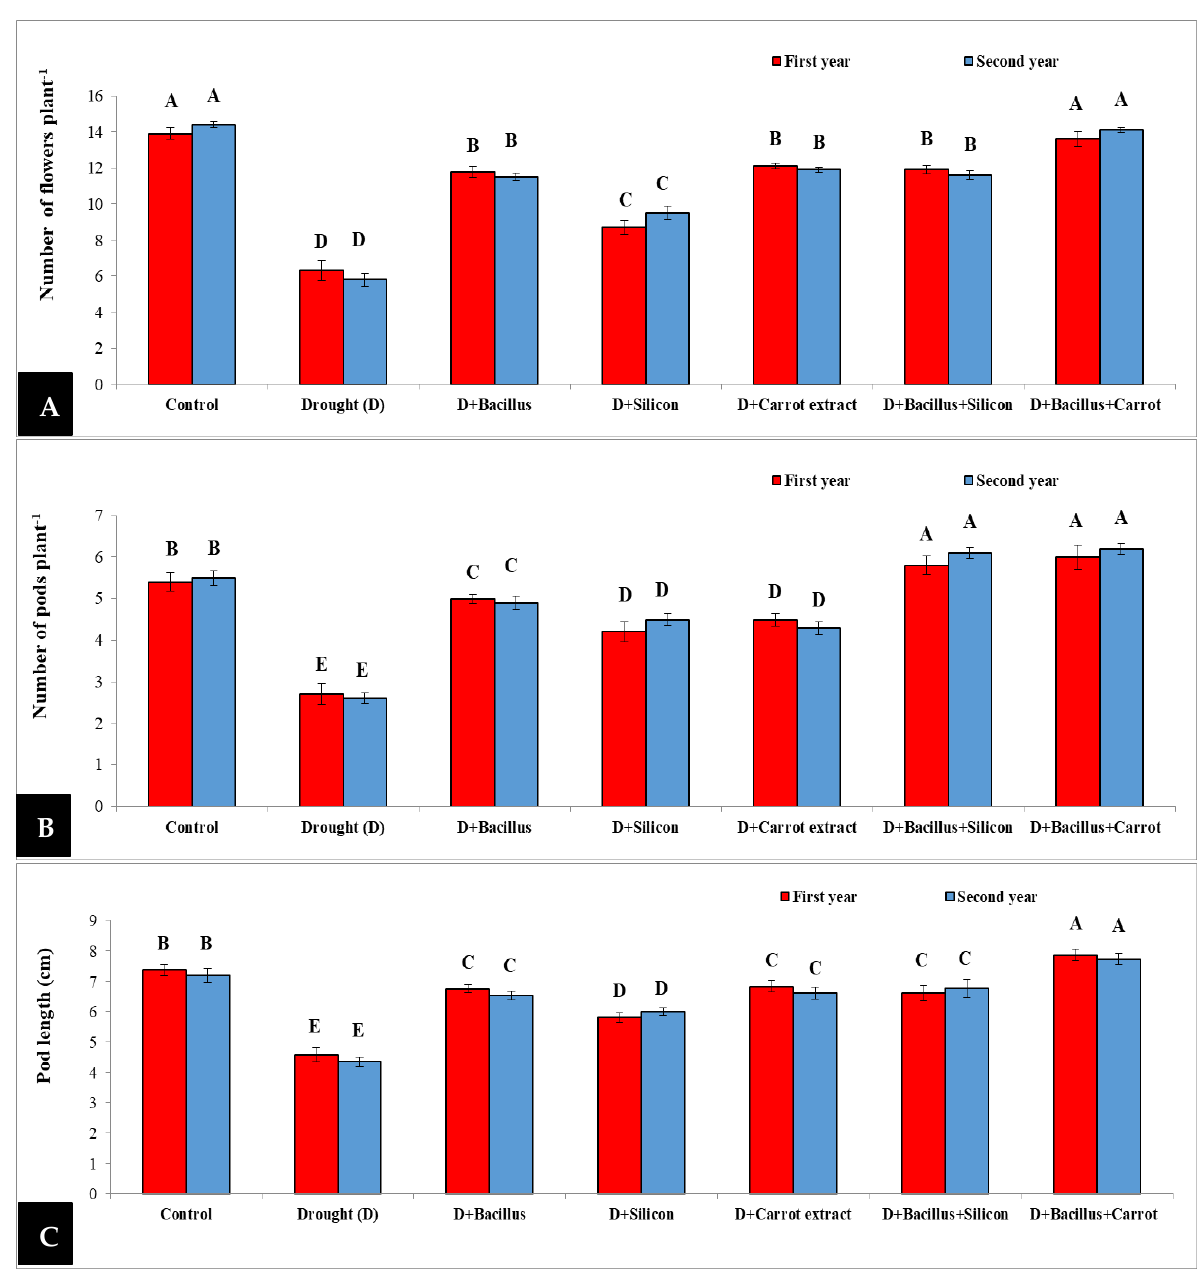
Figure 2. Effect of Bacillus thuringiensis , silicon and carrot extract on number of flowers plant − 1 ( A ), number of pods plant − 1 ( B ) and pod length ( C ) of drought-stressed pea plants during 2019/2020 and 2020/2021 seasons. Different letters on the columns show significant differences between the treatments according to ANOVA, and Duncan’s post hoc test when the result of the omnibus multivariate F-test in ANOVA was significant ( p ≤ 0.05). Data is the mean ( ± SE) of five replicates.